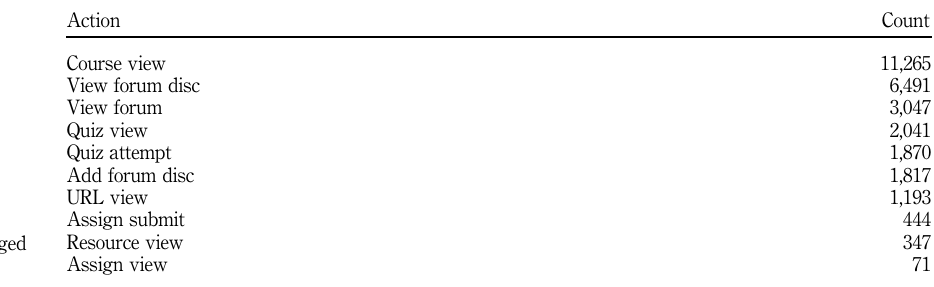
Table V. Statistics on logged student actions